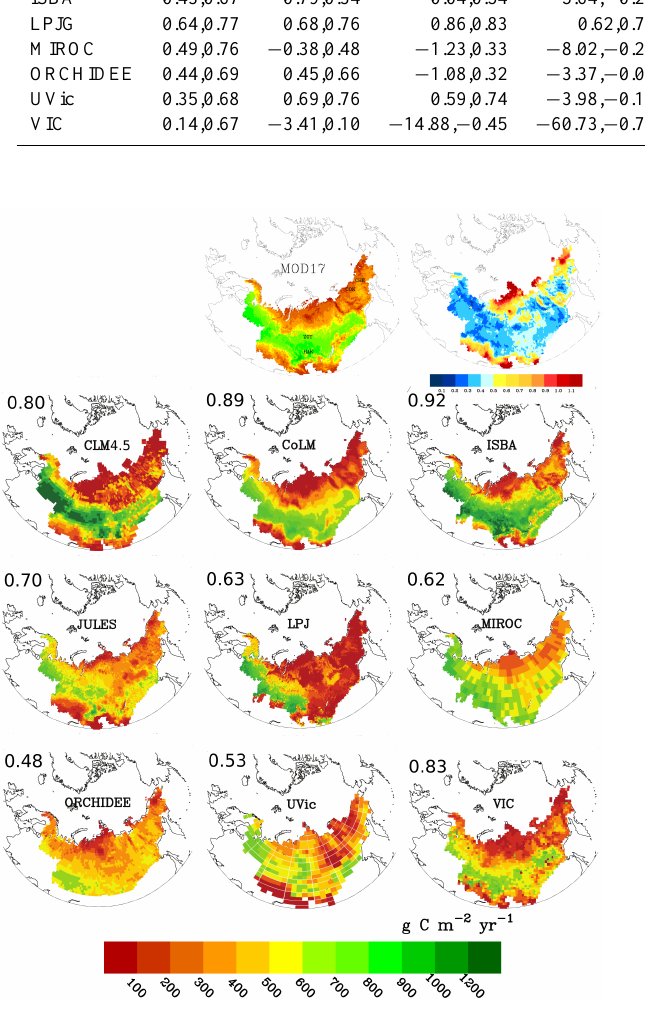
Figure 5. Mean annual gross primary productivity (GPP) from the permafrost RCN models and from the MOD17 product. The averaging period is 2000–2009 for GPP from the MOD17 prod- uct and all models with the exception of CLM4.5 (1995–2004); CoLM (1991–2000); and JULES (1991–2000). Spatial correlations between MOD17 GPP and each model GPP for all grids is shown at upper left in each map panel. Map panel at upper right is coefficient of variation (CV) for GPP. At each grid the CV is estimated from the mean and standard deviation across the nine models (MOD17 not included).